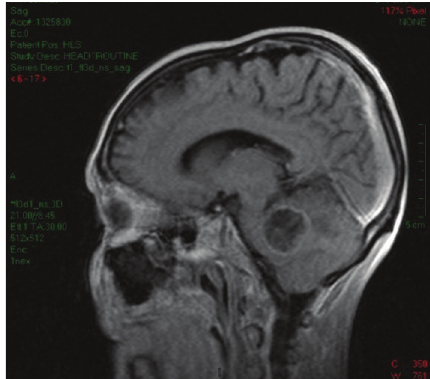
Figure 2: Cystic metastasis. Infratentorial, rim-enhanced hypo- intense lesion revealed by post-contrast T1-weighted MRI image. Department of Neurology, Colentina Clinical Hospital brain imag- ing archive.